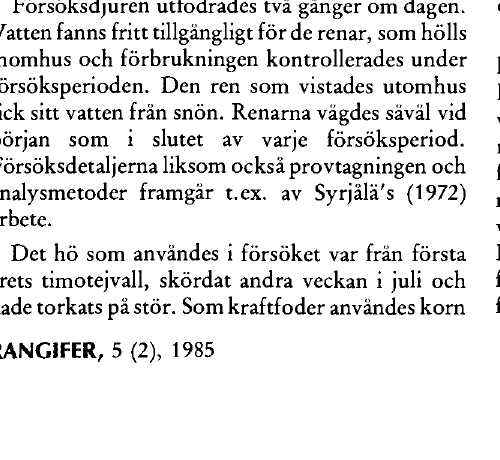
Figur 1. Försöksplan. Figure 1. Trial